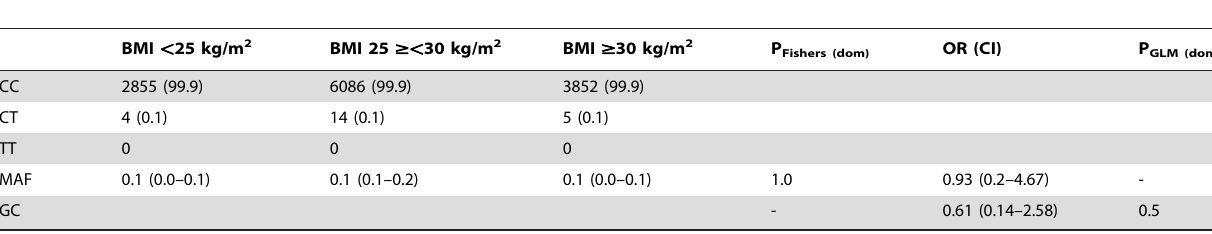
Table 3. Obesity case-control study of the 2 151 C/T GHSR promoter variant in Danes from the Inter99 study, the Danish ADDITION Screening Study and the Steno Diabetes